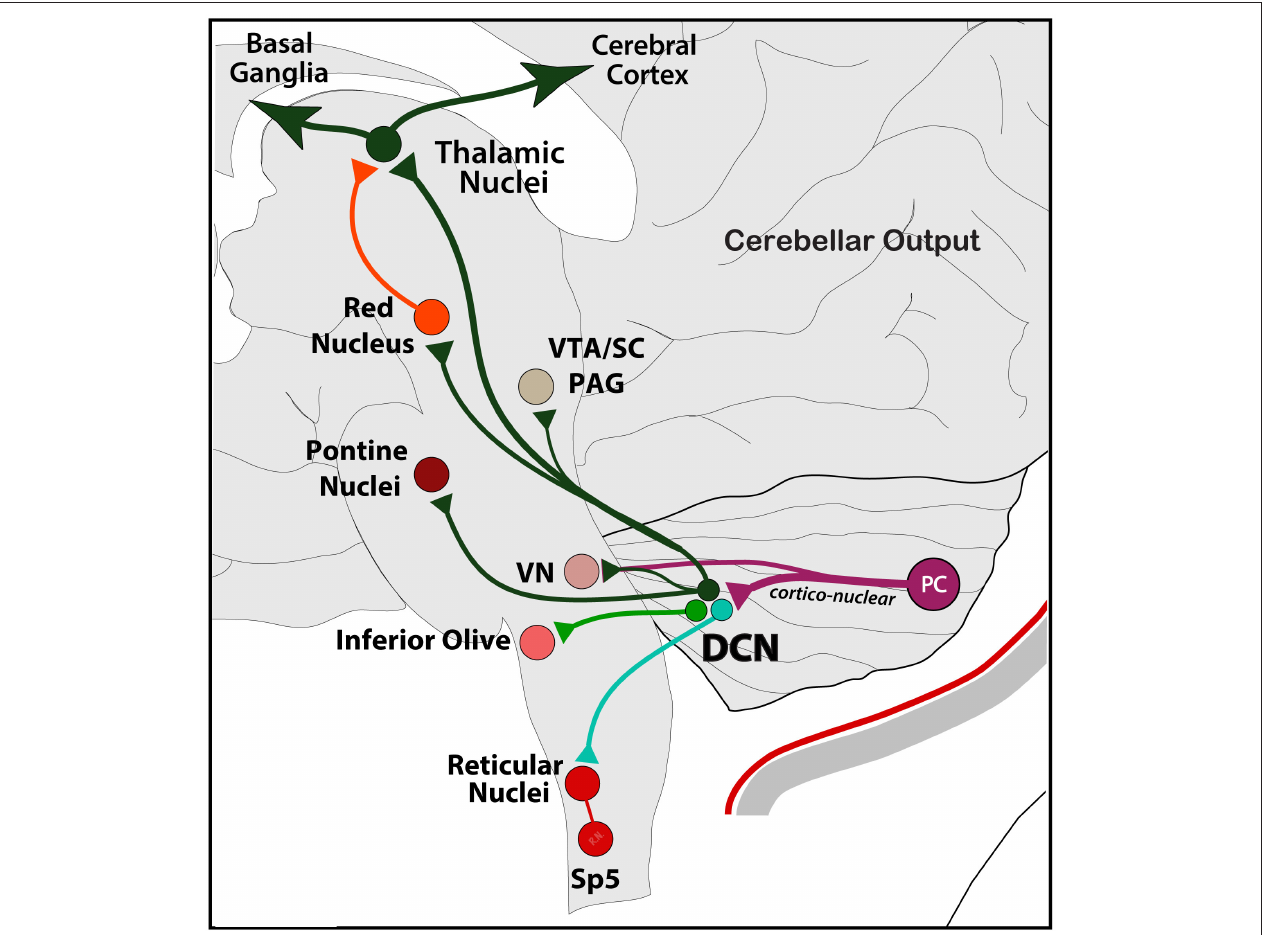
FIGURE 5 | Schematic representation of the main output exiting the cerebellum. From Purkinje cells to DCN ( via cortico-nuclear) and VN, and from DCN to the rest of the brain, including reticular, vestibular, inferior olive, and pontine nuclei in the brainstem; the RN, PAG, SC, and VTA in the midbrain; and thalamic nuclei in the forebrain. Note the poly-synaptic connection with the cerebral cortex and the basal ganglia as part of a main functional network (see text). Output to the hypothalamus is not shown.